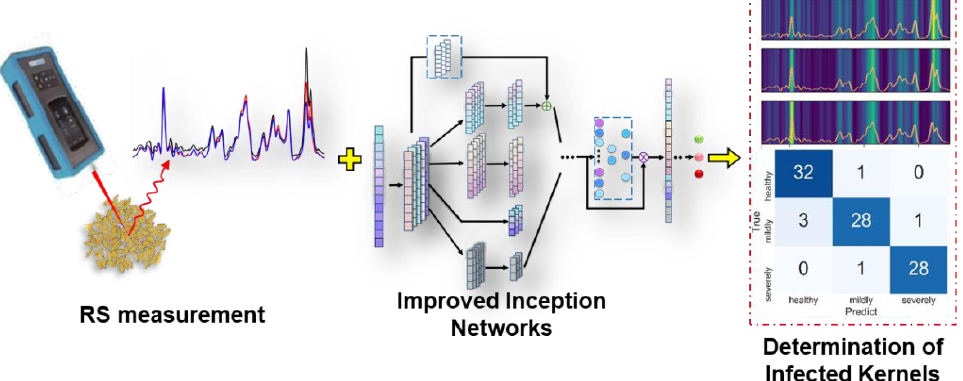
Figure 1. Determination of FHB − infected wheat kernels using RS combined with improved Incep- tion networks.